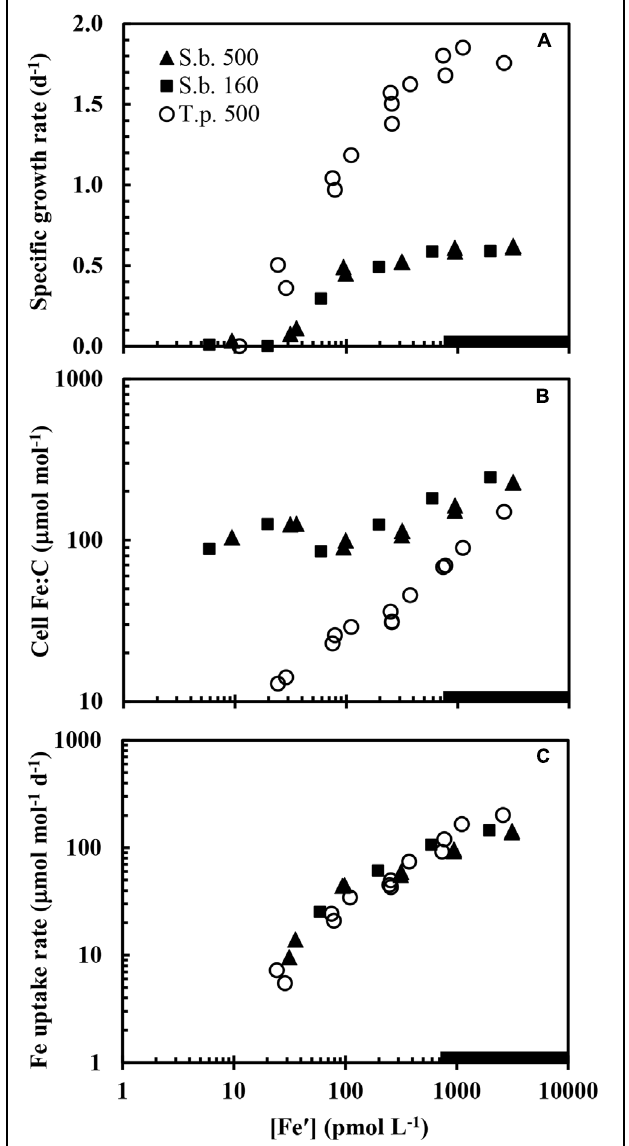
FIGURE 6 | Comparison of (A) specific growth rate, (B) cellular Fe:C, and (C) the cellular iron uptake rate normalized to cell carbon in S. bacillaris in the present study at the two higher light intensities (500 and 160 µ mol quanta m − 2 s − 1 ; solid triangles and squares, respectively) and in the coastal diatom T. pseudonana in previous experiments (Sunda and Huntsman, 2011) measured at high light intensity (500 µ mol quanta m − 2 s − 1 ; open circles) and the same temperature and photoperiod. Data for S. bacillaris at high light (500 µ mol quanta m − 2 s − 1 ; solid triangles) are for both low Cu and high Cu cultures ([Cu 2 + ] = 0.16 and 16 pM,